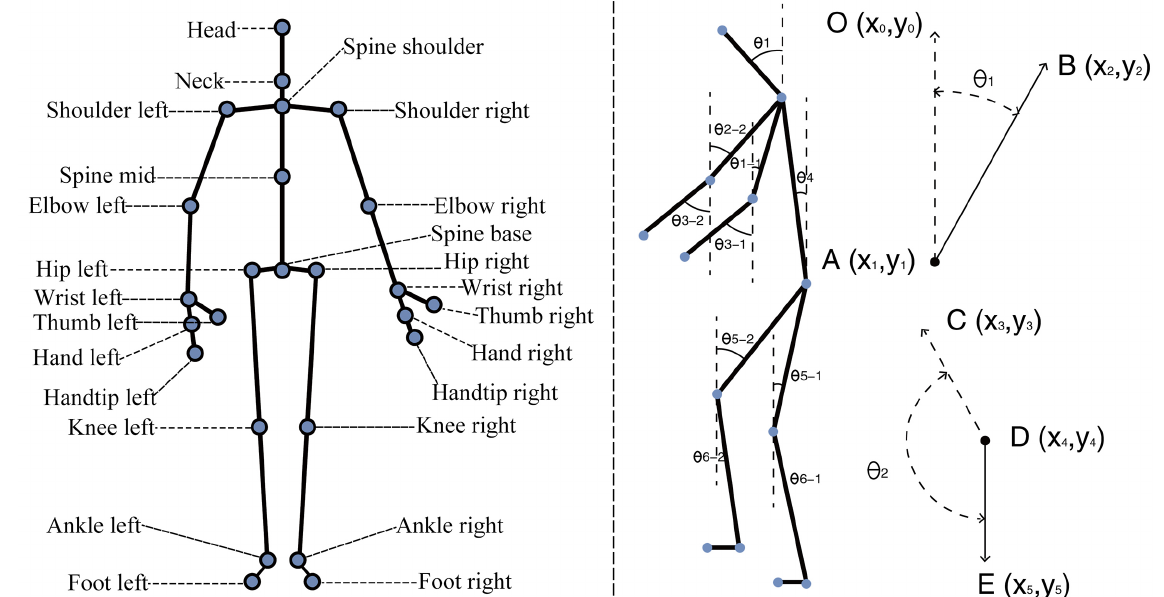
Figure 3. Summary of 25 skeletal key points and 12 key joint